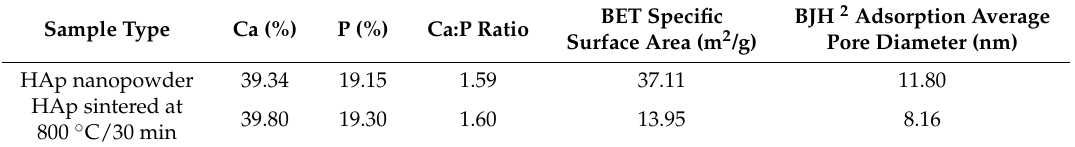
Table 1. Chemical analysis, BET 1 surface area and pore size. HAp: Hydroxyapatite.